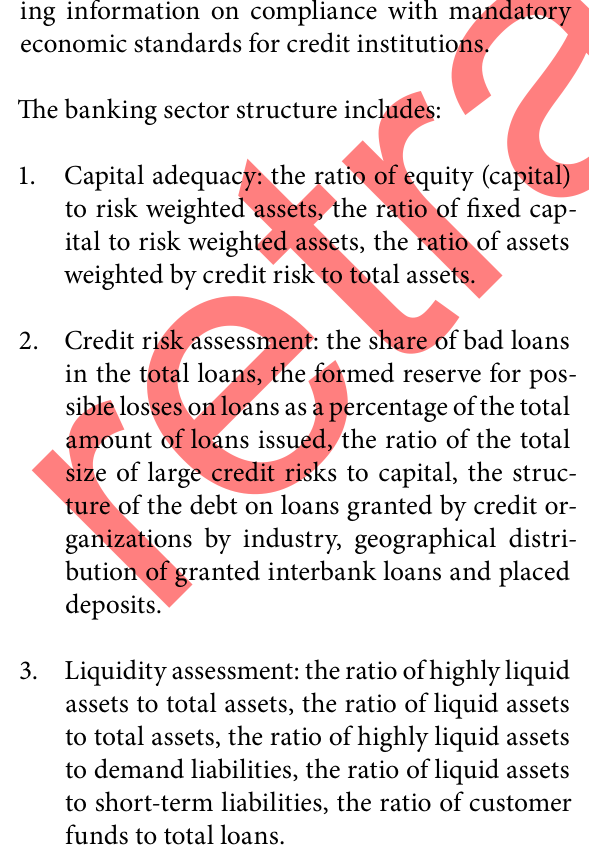
Table 1. Factors of crises in the banking